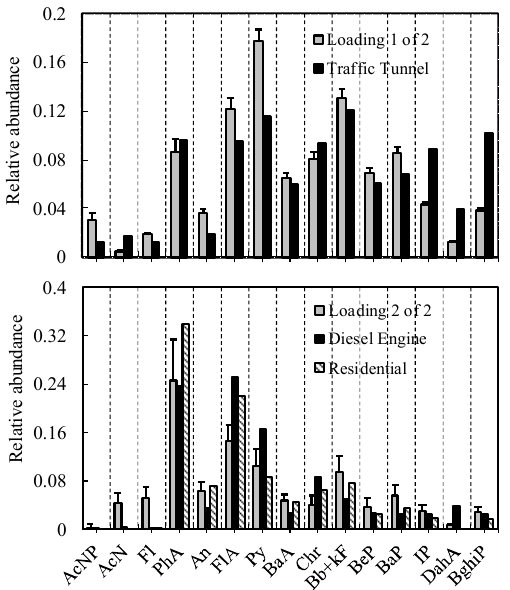
Figure 2. Factor loading plots of sediment PAH two-source factor analysis solutions with error bars representing the standard deviation of the mean derived from the Monte Carlo uncertainty analysis.